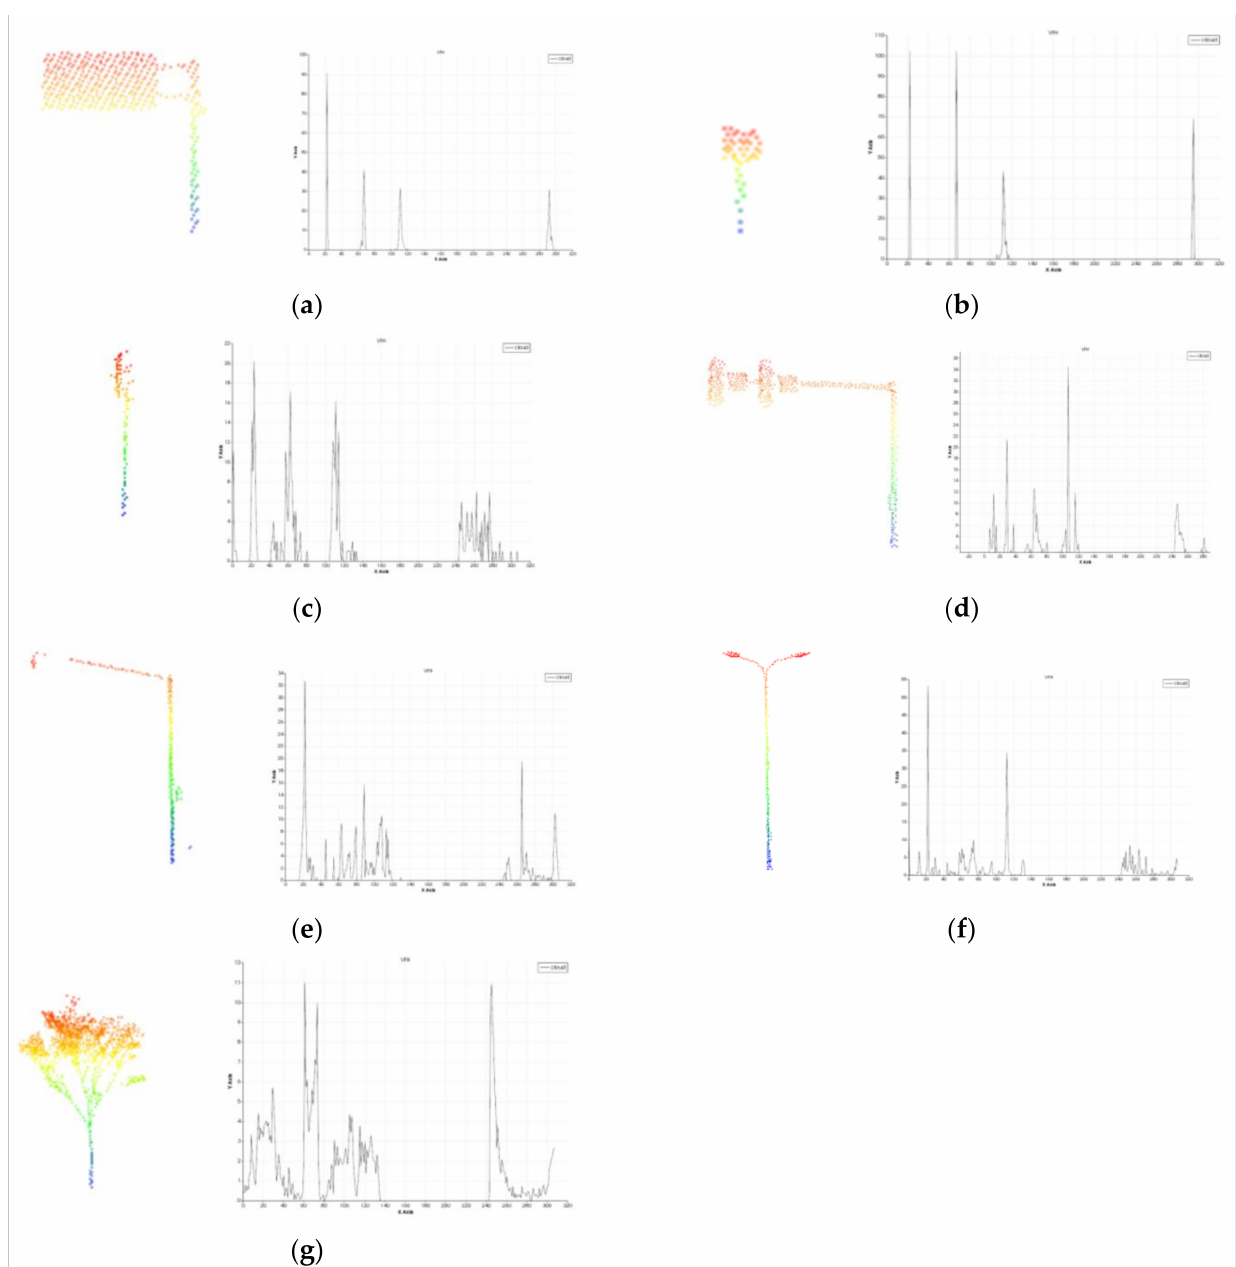
Figure 12. The ( a – g ) respectively represent the VFH characteristics of different types of pole-like